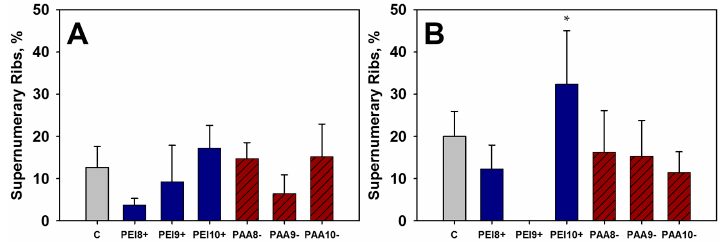
Figure 1. Supernumerary rib observations from fetuses of mice treated with 10 mg/kg ( A ) or 100 mg/kg ( B ) of iron oxide NPs and the control, C, on various days of gestation (GD 8, 9, or 10). * Significant differences between treatment group and the control ( p < 0.05).